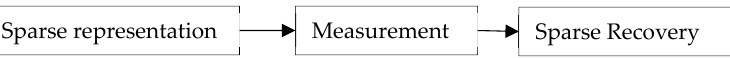
Sparse Recovery Figure 9. Block diagram of compressive sensing Figure 9. Block diagram of compressive sensing [53,54,56,67].